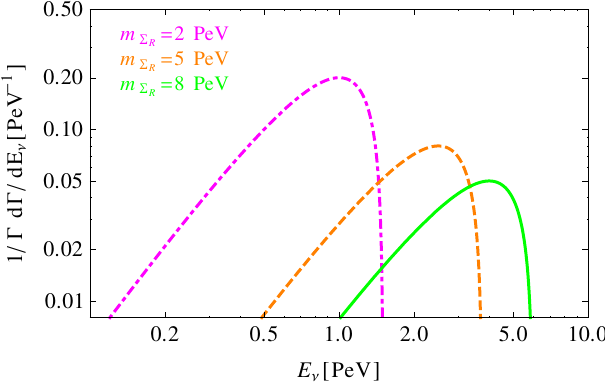
Figure 8 . Normalised energy distribution of the primary neutrinos coming from the DM decay (cid:6) 0 (cid:6) 0 (cid:22) (cid:23) ‘ (cid:23) ‘ for various masses of (cid:6) 0 R ! L